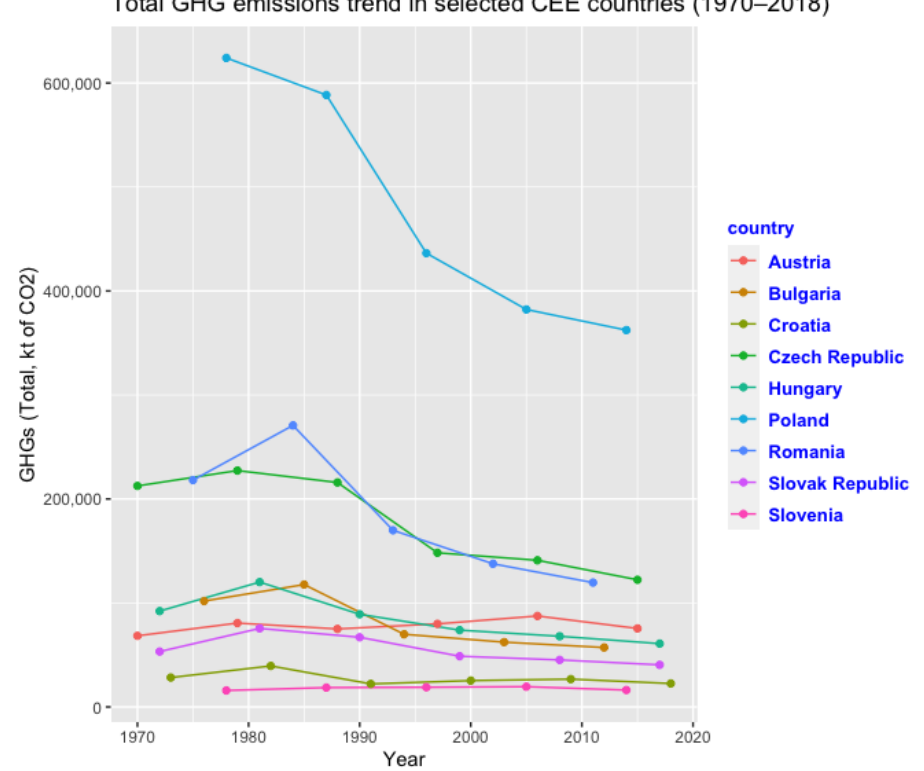
Figure 3. Total GHG emission trends in CEE countries. Authors’ representation. Source of data: World Development Indicators (WDI).